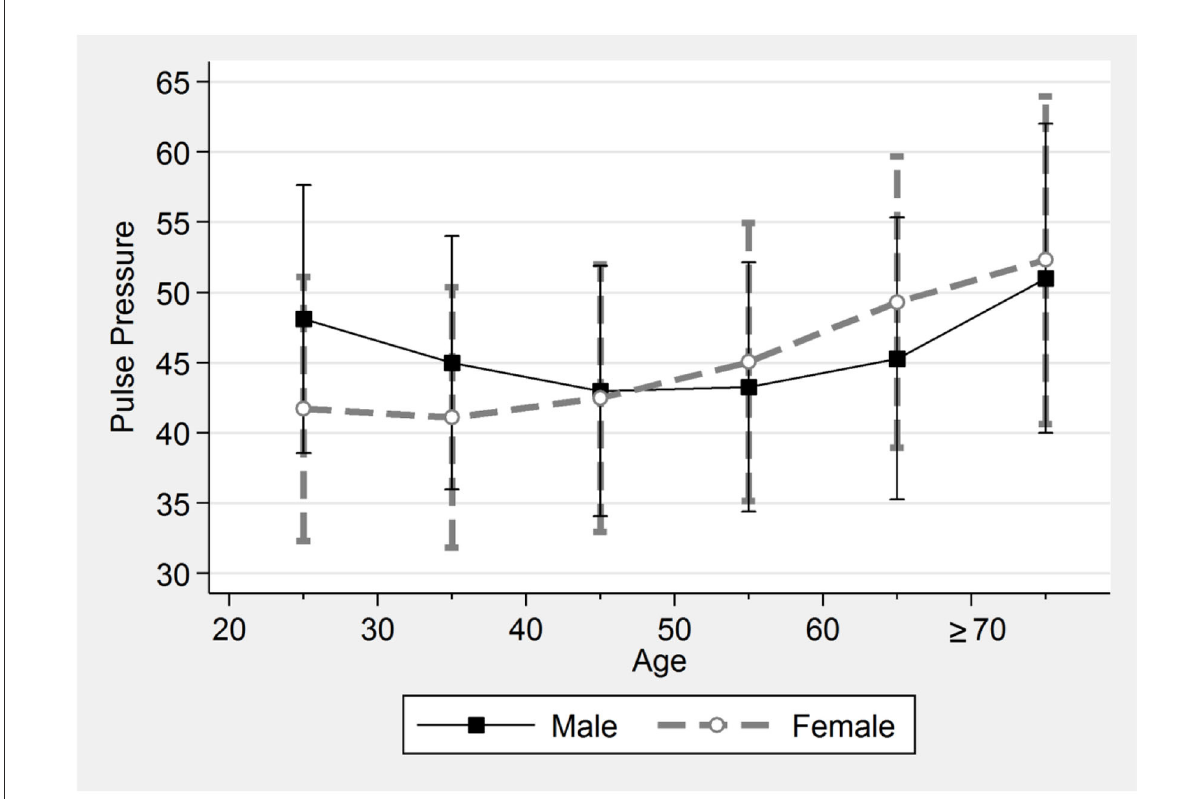
FIGURE1 Pulse pressure by sex and age. The J-shape curves demonstrate the non-linear relationship between age and PP for male and female subjects. PP in female subjects becomes greater than in male subjects after the age of 50